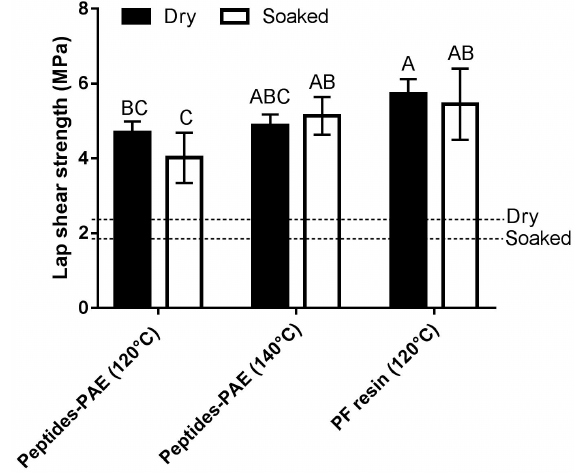
Figure 5. Comparison of adhesive performance of peptides–PAE resin to that of a commercially-available phenol–formaldehyde (PF) resin. Specimens were hot pressed at 3.5 MPa for five min at hot pressing temperature shown in parenthesis. Error bars are standard deviation of six plywood specimen measurements. Means that do not share a letter are significantly different (Tukey, 95% confidence level). The minimum shear strength requirements as specified by ASTM D4690 are indicated.